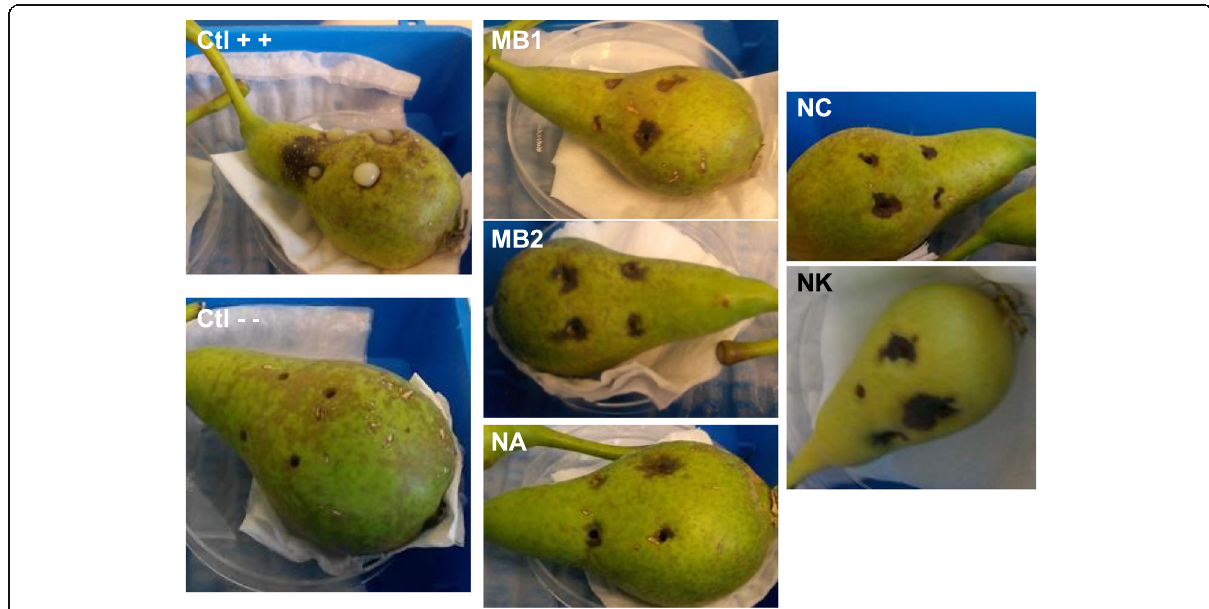
Fig. 4 Protection of pear immature fruits against Erwinia amylovora by different selected bacteria antagonist ( Serratia plymuthica and Pseudomonas fluorescens ). The tests were carried out under T and RH conditions at a concentration of 10 6